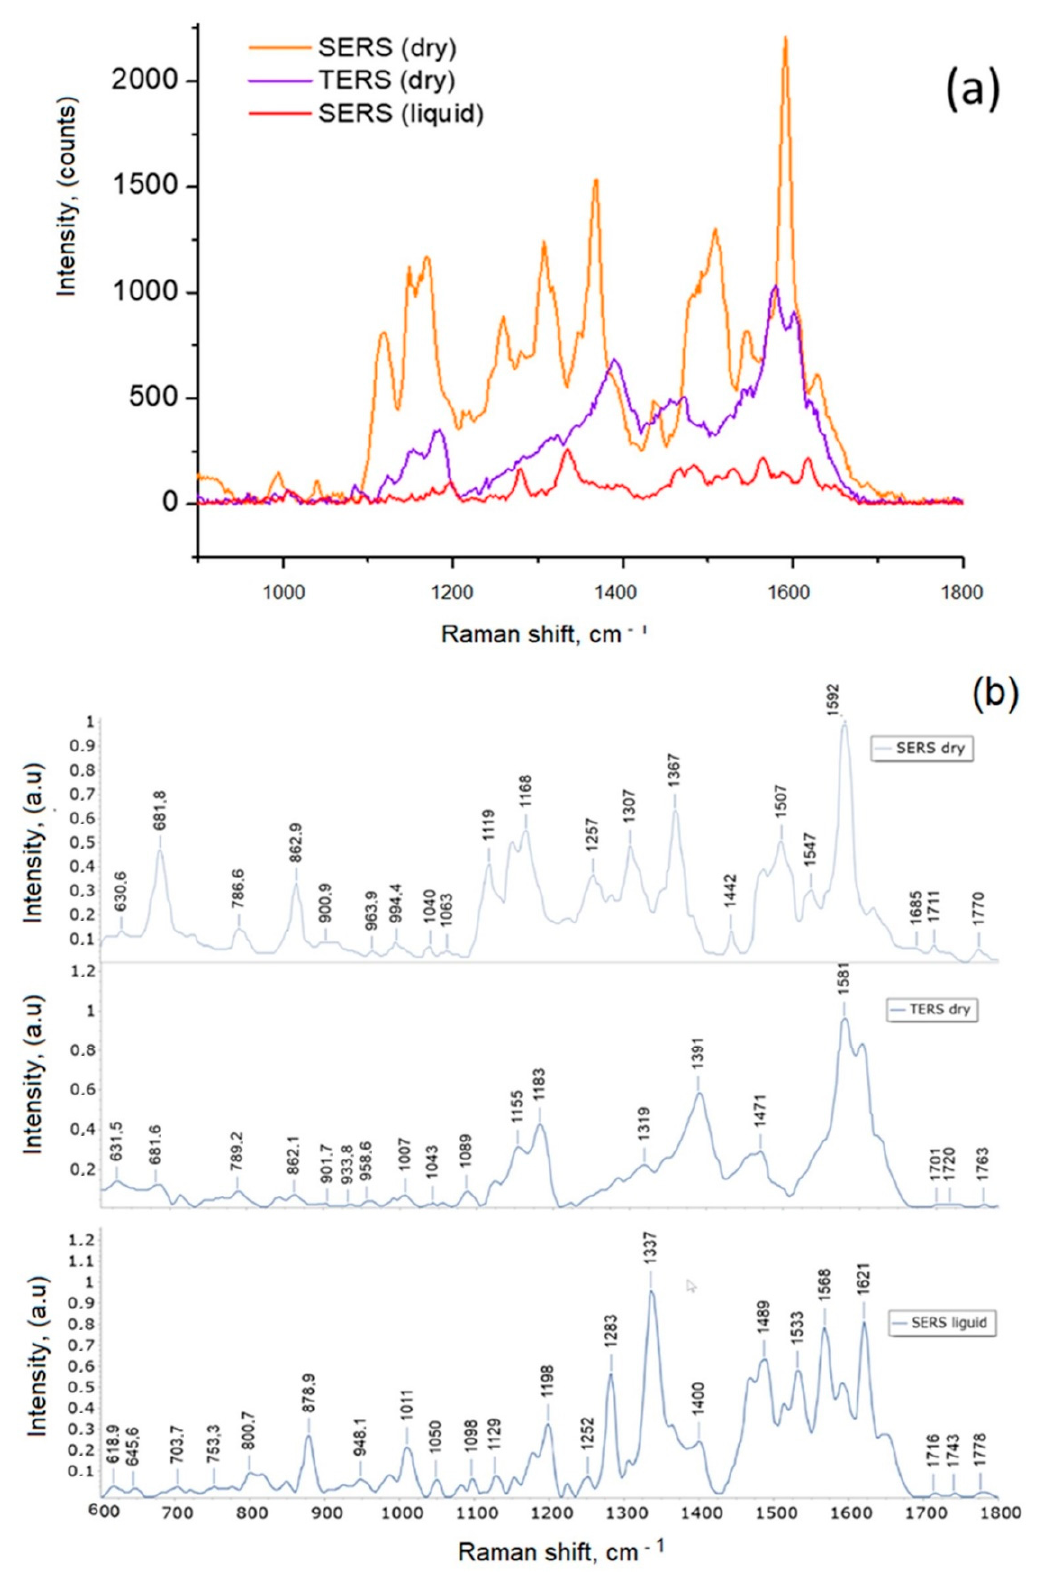
Figure 8. ( a ) Registered Raman spectra; ( b ) normalized spectra, of TiO 2 - α -Syn NP.